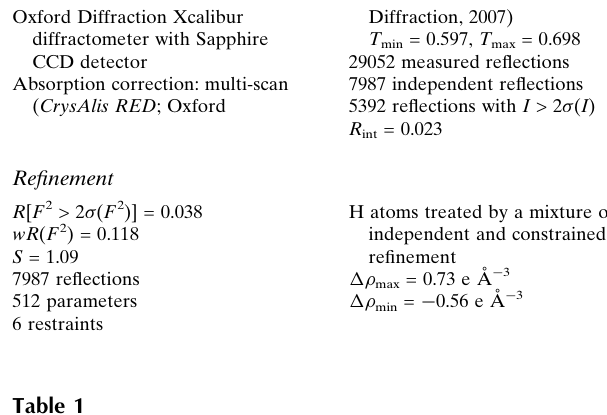
Selected geometric parameters (A˚ , (cid:2) ).